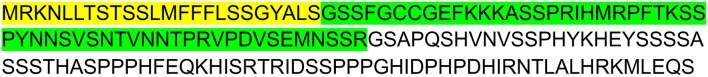
Las5315mp secreted effector sequence and its predicted C-terminal chloroplast targeting domain. Amino acid sequence of Las5315mp with N-terminal signal peptide (highlighted in yellow) predicted using SignalP v4 (Petersen et al., 2011), the cleavage site between 24 and 25 amino acid positions (ALS-GS), and the chloroplast targeting (highlighted in green) predicted using ChloroP v1.1 (Emanuelsson et al., 1999).